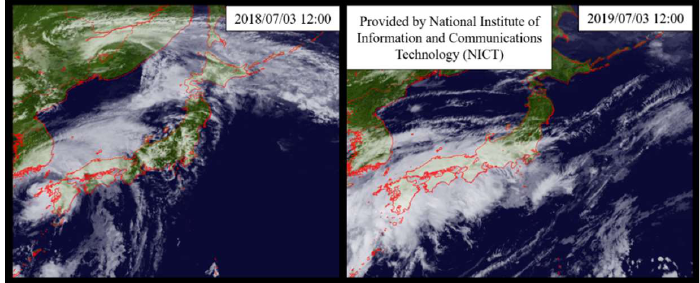
/ 07 / 03 at 12:00 and on 2019